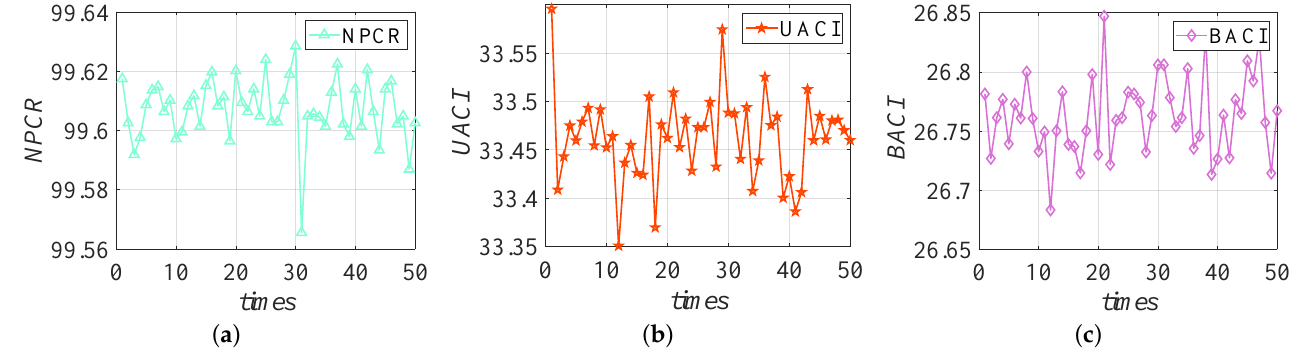
Figure 11. NPCR ( a ), UACI ( b ) and BACI ( c ) values obtained from 50 experiments.